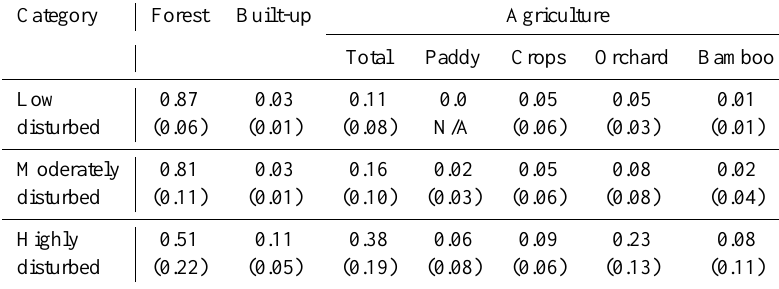
Table 3. Relative land cover composition of the three categories of